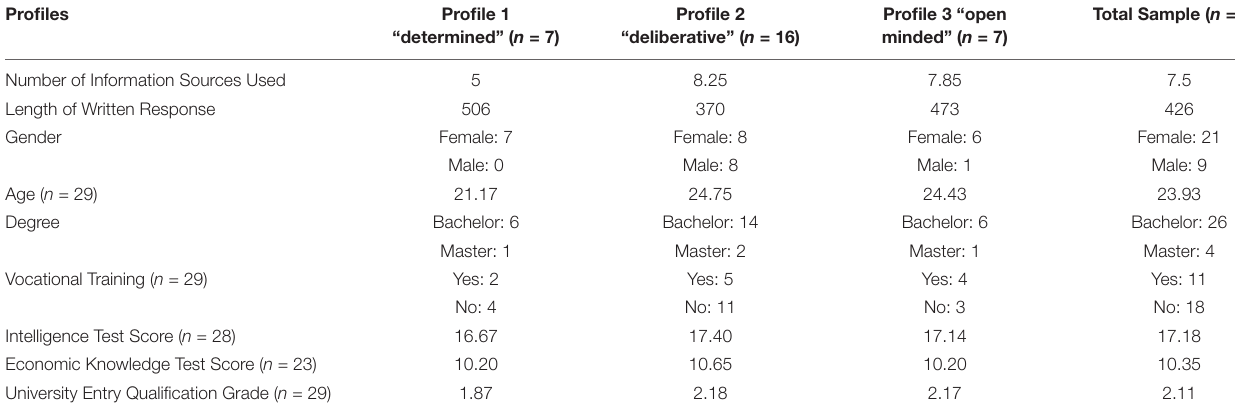
TABLE 4 | Characteristics of the three decision-making